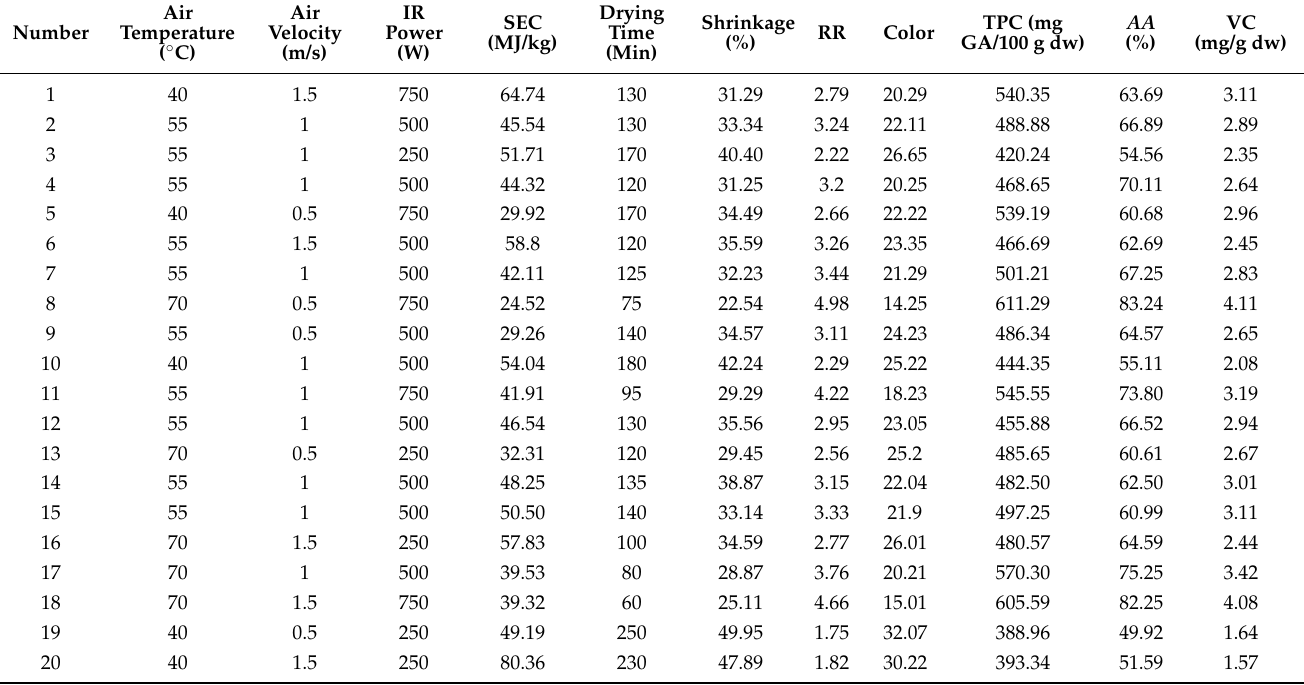
Table 3. Experiment design and value of dependent variables at different levels of independent